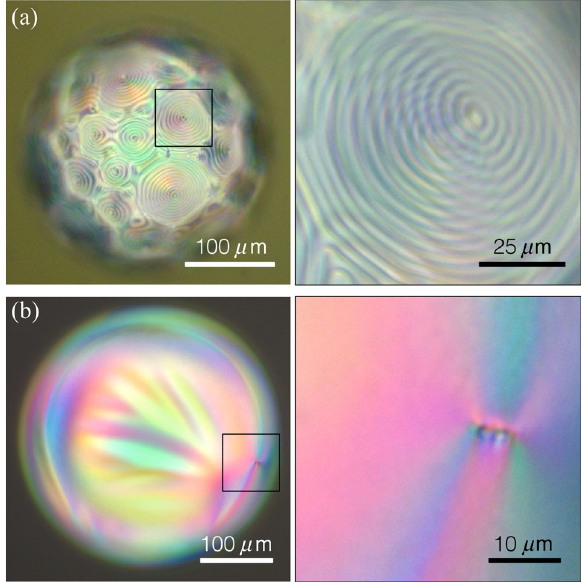
FIG. 2. Focal conic domains (FCDs) form on inner shell surface. A CLC shell has 5 mM SDS, 1 M NaCl, and 1% PVA in the inner phase water phase and 5 mM SDS, 0.1 M NaCl, and 1% PVA in the outer phase. FCDs can only be created on the inner shell surface alone when an extreme concentration of salt (1 M NaCl) is added to the inner water phase. (a) Before the shell completes osmotically swelling, FCDs, formed from the inner shell, are seen (zoom-in, right). The high salt concentration screens the SDS surfactant head group, allowing the surfactant to pack more densely on the interface. (b) After one day, the shell completes its swelling. The surfactant and salt concentrations are decreased, and the FCDs disappear as the inner salt concentration matches the outer salt concentration. The shell has mostly planar anchoring on its surface, apparent from the defect required from concentric cholesteric layers (zoom-in,